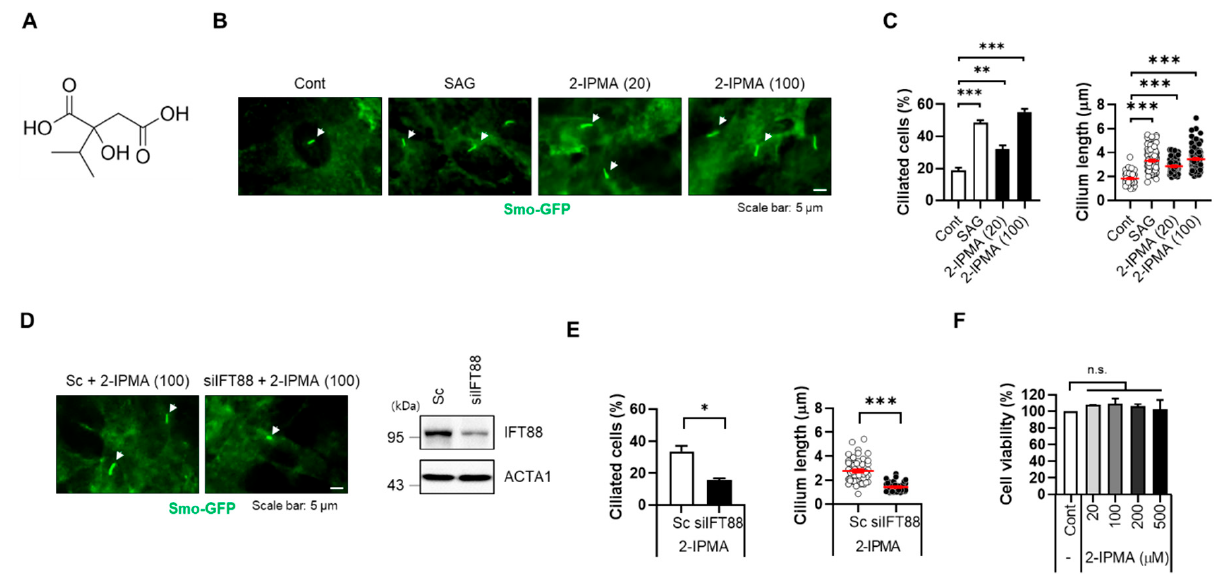
Figure 1. 2-IPMA promotes primary ciliogenesis in RPE cells. ( A ) Chemical structure of 2-isoproylmalic acid (2-IPMA). ( B , C ) RPE cells stably expressing Smo-GFP (RPE/Smo-GFP) were treated with either SAG (1 µ M) or 2-IPMA (20 or 100 µ